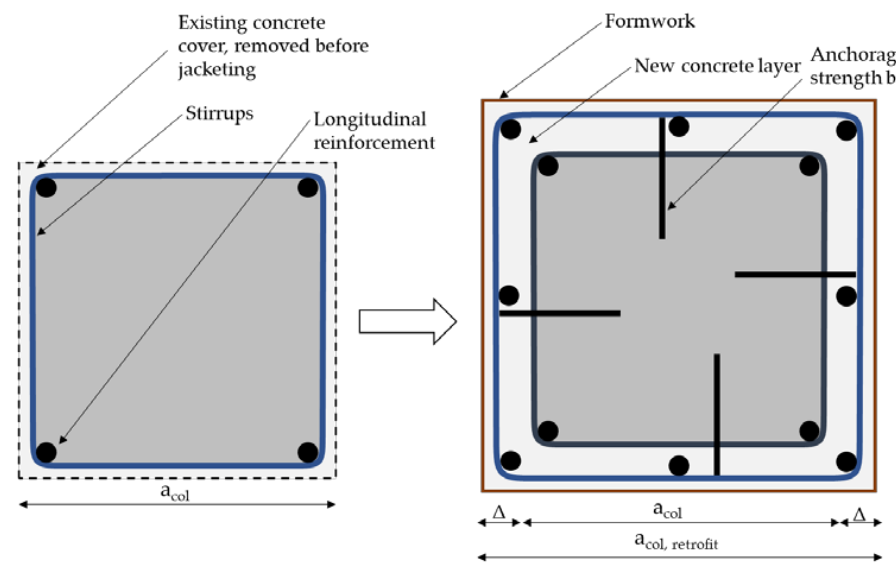
Figure 2. An example of reinforced concrete jacketing of existing columns.